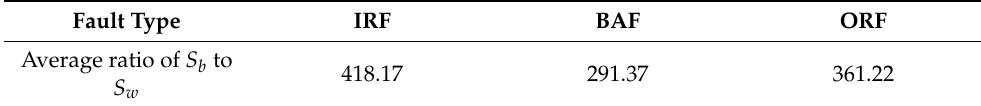
Table 2. The ratios of S b to S w for each fault type.